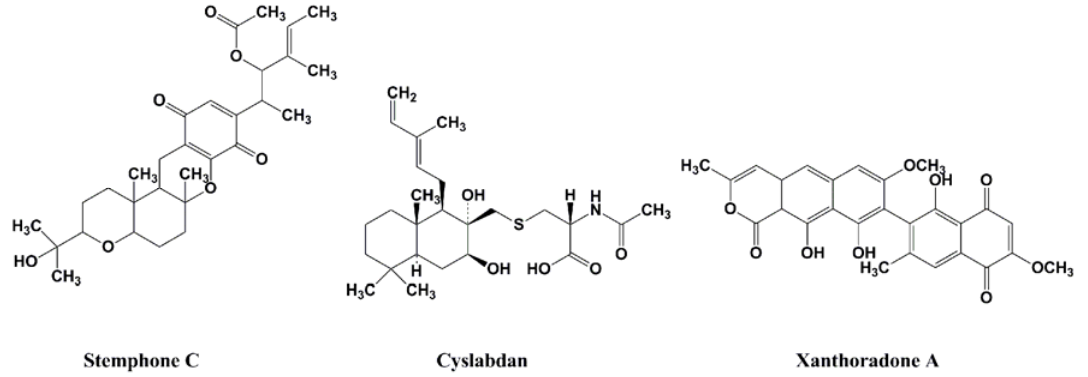
Figure 6. Structures of stemphone C, cyslabdan, and xanthoradone